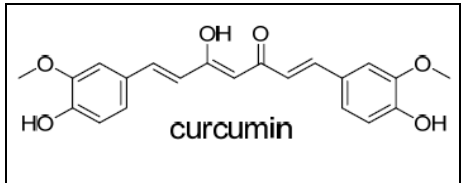
Figure 1: The chemical structure of curcumin.